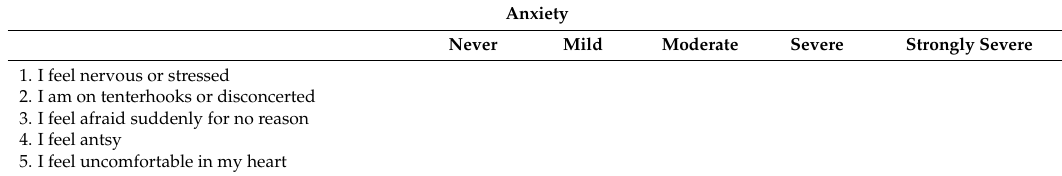
Table A2. Mental health